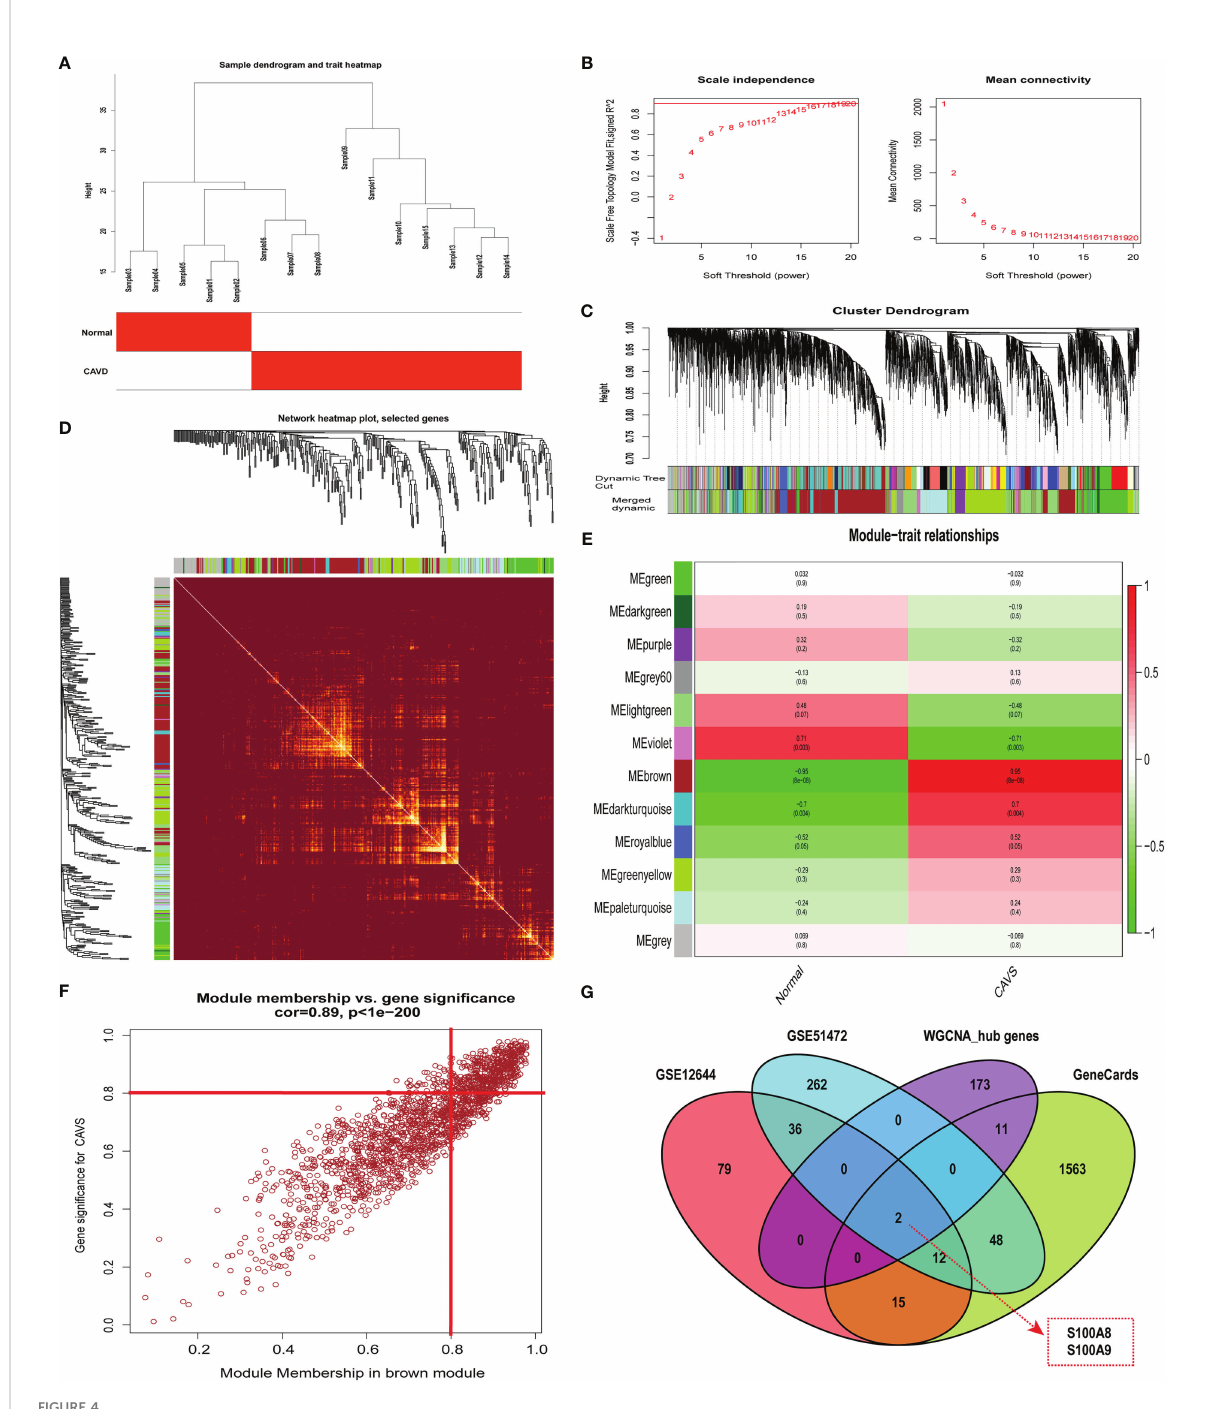
FIGURE 4 Weighted co-expression network analysis (WGCNA) of GSE12644 dataset and Venn diagram to obtain the key genes S100A8 and S100A9 . (A) Sample clustering of the GSE12644 dataset. The sample was clustered into two signi fi cantly different clusters. (B) Selection of optimal thresholds. The threshold was 16. (C) By aggregating genes with strong correlations in the same module, different modules were obtained and are displayed in different colors. (D) A network heatmap plot was created through WGCNA showing overall module-related gene branches in hierarchical clustering dendrograms. (E) Correlation analysis between modules and calci fi c aortic valve disease (CAVD). (F) The brown module was signi fi cantly positively correlated with CAVD (COR = 0.95, P < 0.001). The genes in the brown module are labeled as the WGCNA-hub genes. (G) Intersection of GeneCards, WGCNA, and differential expression data, displayed in the Venn diagram. The two most signi fi cant genes, S100A8 and S100A9 , were